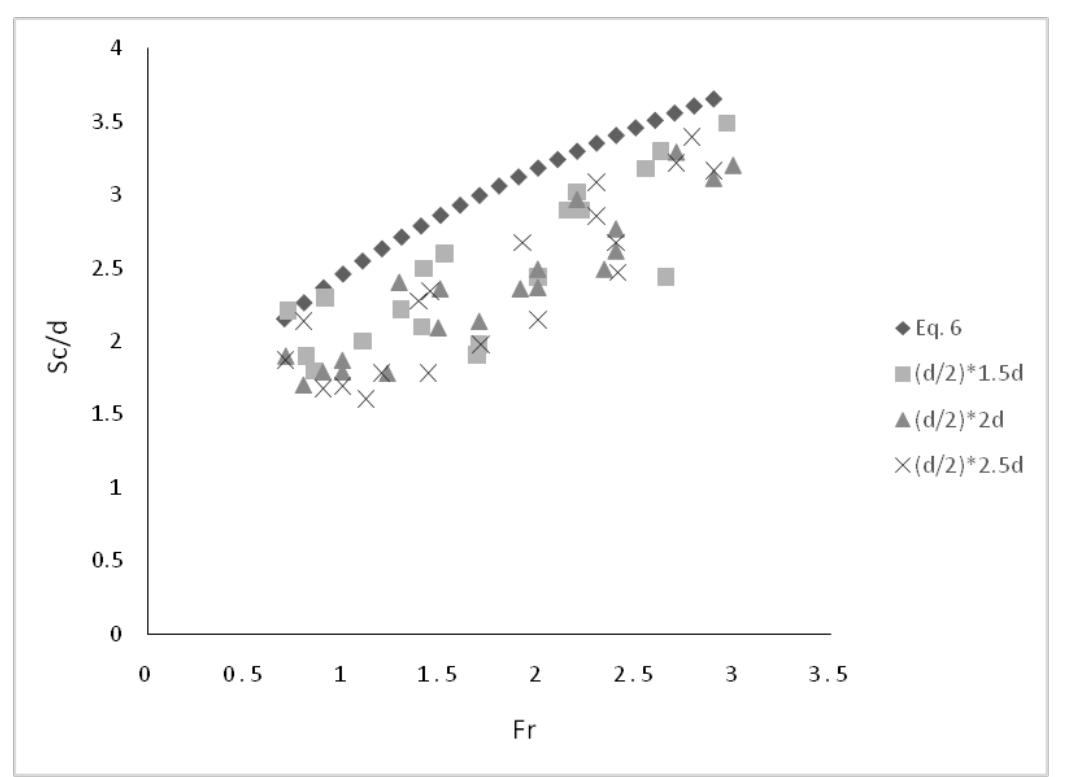
Fig. 8 The experimental results of the critical submergence at various Froude numbers. (Plates with height of d/2)